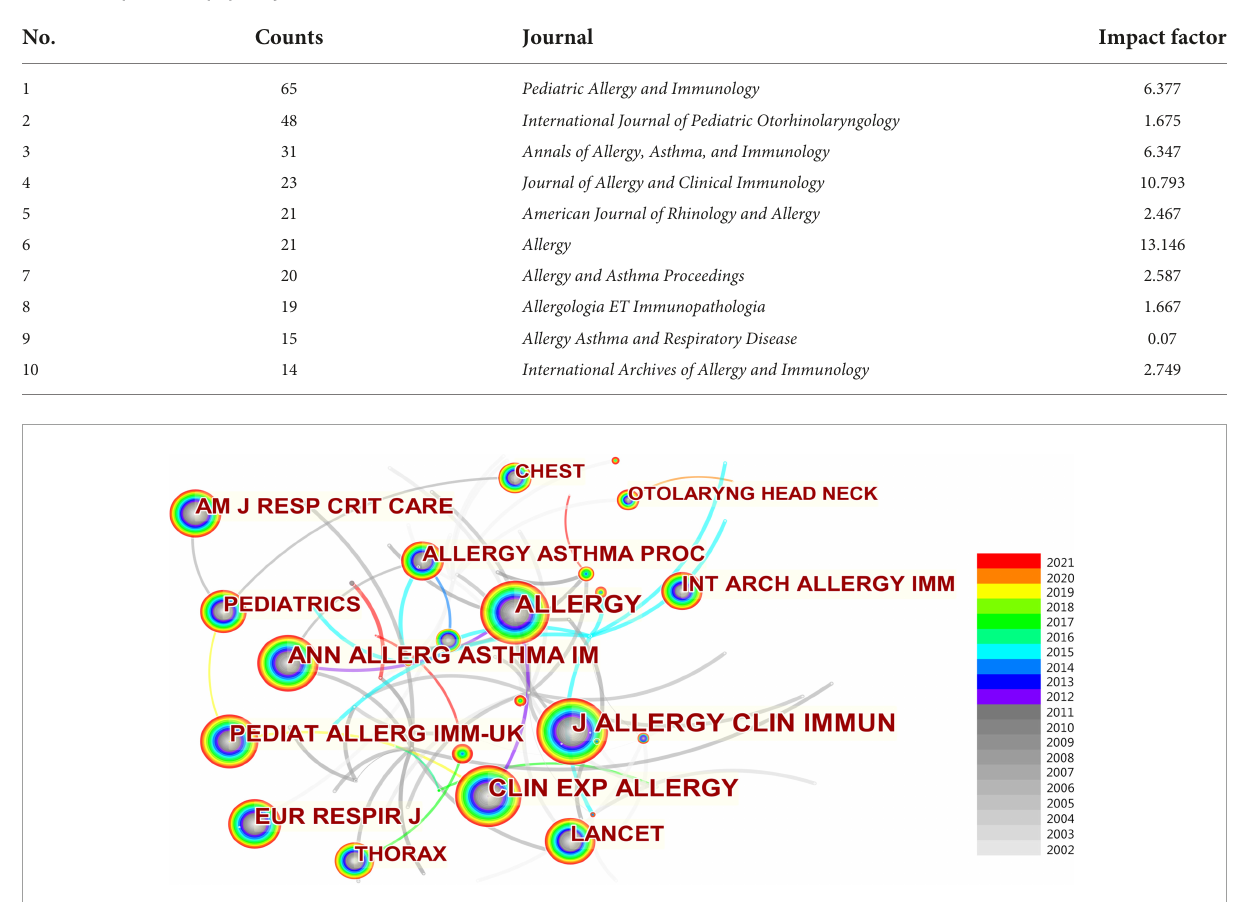
FIGURE6 Co-cited Journals of AR research in